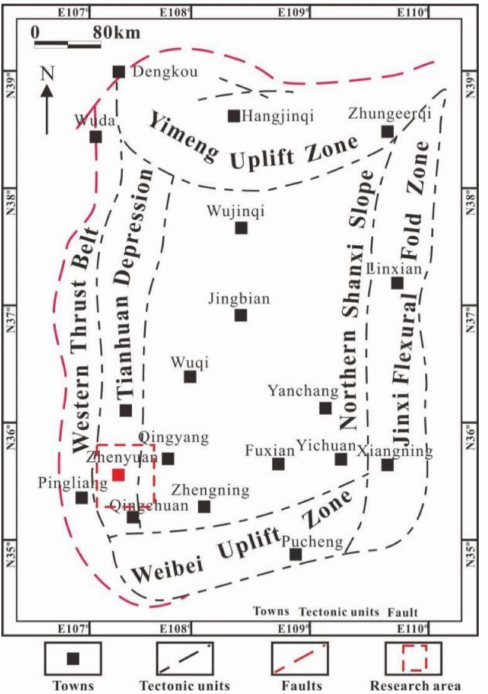
Figure 2. Tectonic location map of Zhenyuan area, Ordos Basin,